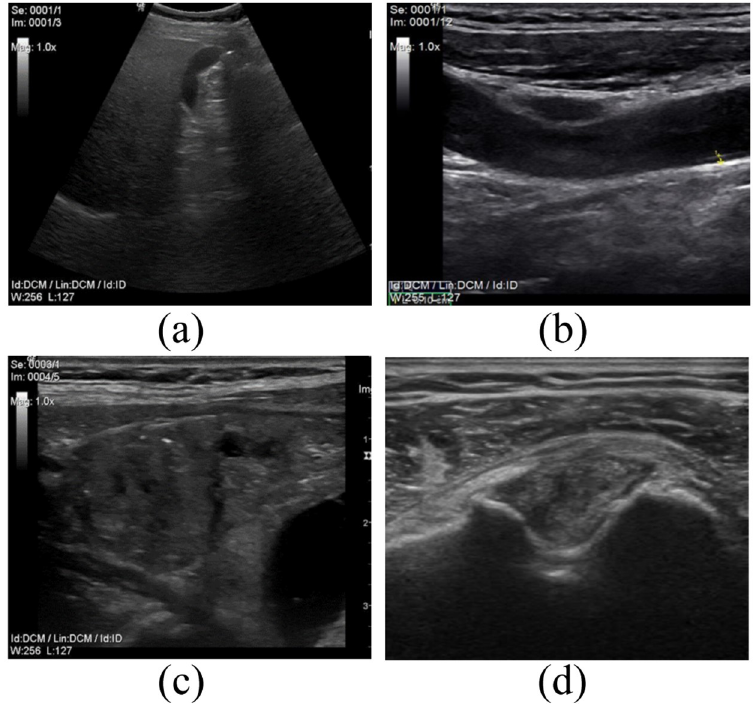
Fig 2. Examples of the ultrasound images from all four cathegories of the created database: Abdominal (a), Carotids (b), Neck (c), and Musculoskeletal system (d).